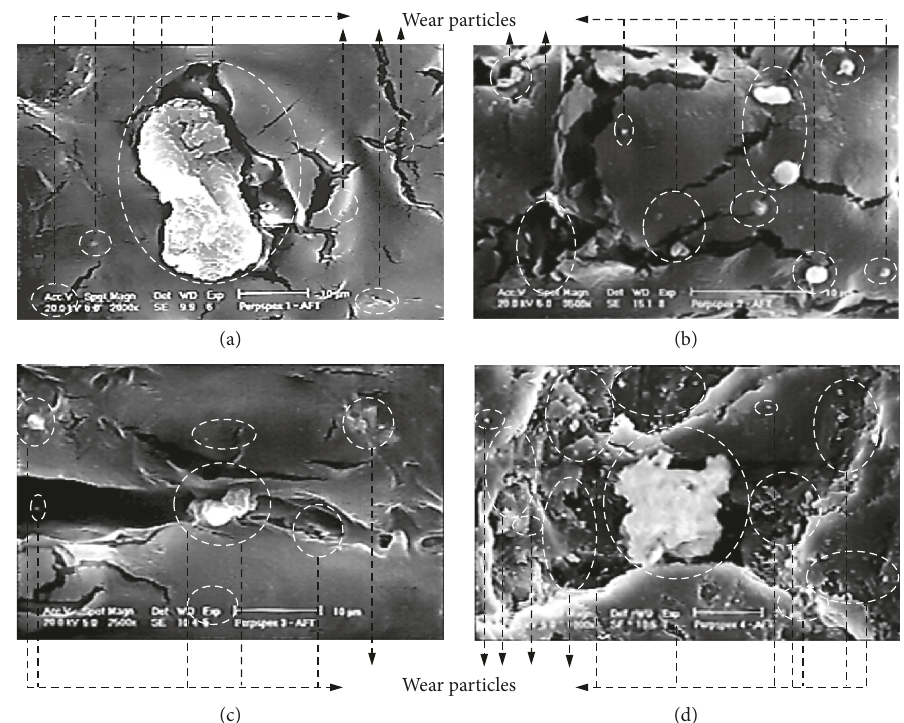
Figure 5: Photoelectron micrographs for the wear particles from rubbed tracks of the PMMA surfaces after the dynamic friction tests (ADFT): (a) PMMA1, (b) PMMA2, (c) PMMA3, and (d)